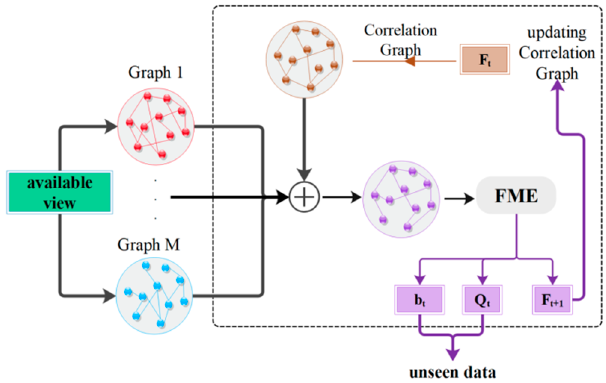
Figure 1. The framework of the proposed method. The available view of data is demonstrated in green color. Different graphs are created according to available data. The brown-colored graph is built on the view of the label space. All the graphs are fused. The resulted graph is given to the flexible manifold embedding (FME) algorithm. In the final iteration, the projection matrix and bias vector are used for predicting the labels of the unseen data.